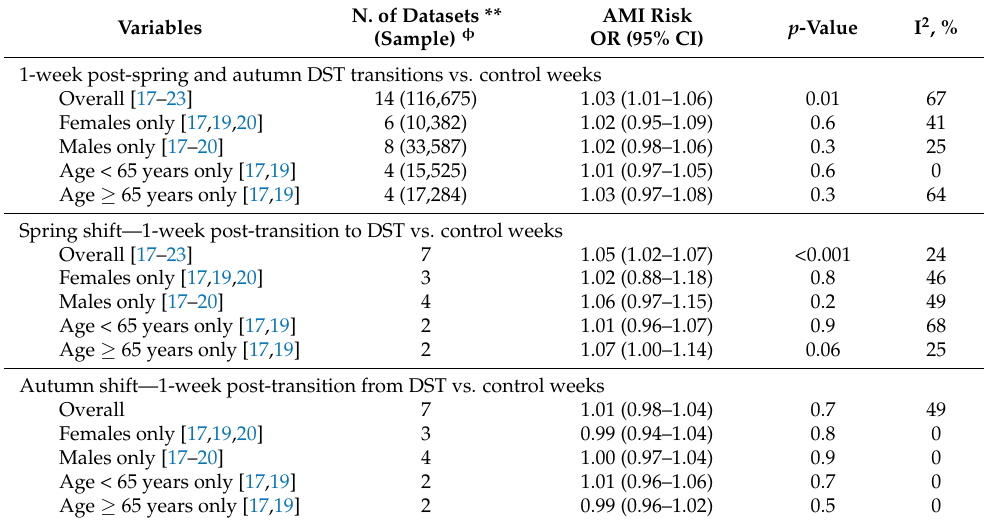
Table 3. Risk of acute myocardial infarction (AMI) during the first week following daylight saving time (DST) transition versus control weeks *, overall and according to selected study characteristics. All meta-analyses are based upon a generic inverse-variance